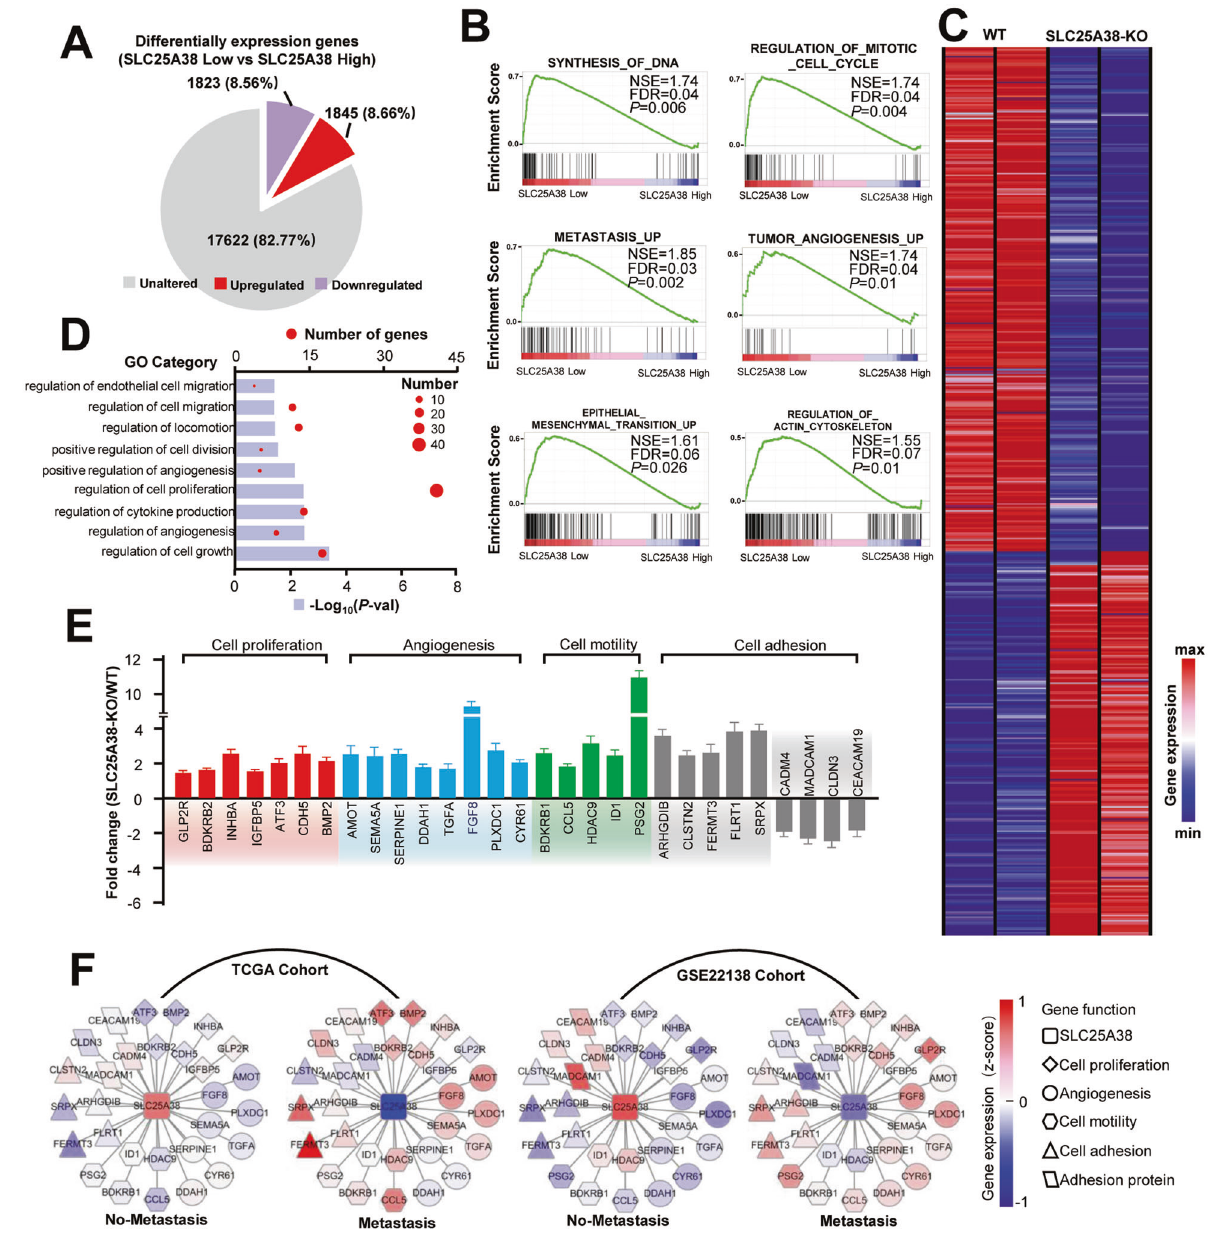
Fig. 3 SLC25A38 is the upstream of several metastasis-related pathways. A Pie chart illustrating differentially expression genes between SLC25A38-low tumors and SLC25A38-high tumors in TCGA UM RNA-seq dataset. B GSEA showing that SLC25A38 expression was negatively correlated with proliferative and metastatic gene signatures in the TCGA UM dataset. C Heatmap showing differentially expression genes in UM cells with SLC25A38 knock-out relative to control cells. D The most signi fi cant differentially GO items upon SLC25A38 knock-out. E Differentially expression genes in the SLC25A38-silenced UM cells in the indicated signaling pathways analyzed by qRT-PCR. F These series of networks demonstrated the changes in SLC25A38 and its neighboring genes (involving in cell proliferation, cell adhesion, cell motility, and angiogenesis) in terms of expression during metastasis in TCGA UM specimens and GSE22138 tumors. angiogenesis compared to non-metastatic tumors in both TCGA UM cells with or without SLC25A38 knock-out. As expected, cohort and GSE22138 cohort (Fig. 3F). The above evidences knock-out of SLC25A38 lead to great changes in cell proliferation, indicated that SLC25A38 is situated upstream of metastasis- adhesion, migration, and vascular growth ( P adj < 0.05, fold related pathways. change > 1.5; Fig. 3C, D), which coincided with the bioinformatic results of tumors from TCGA cohort. The validation of PCR also Knock-out of SLC25A38 promotes the metastasis and demonstrated an upregulated level of molecules related to cell angiogenesis in UM growth, adhesion, and angiogenesis upon knock-out of SLC25A38 Given that GNAQ/11 was the most frequent mutation in UM and (Fig. 3E). Further analyses showed that metastatic cases tended to closely related to the prognosis of UM, we found that the have lower SLC25A38 expression and higher levels of molecules expression level of SLC25A38 was signi fi cantly different between involving in cell proliferation, cell adhesion, cell motility, and